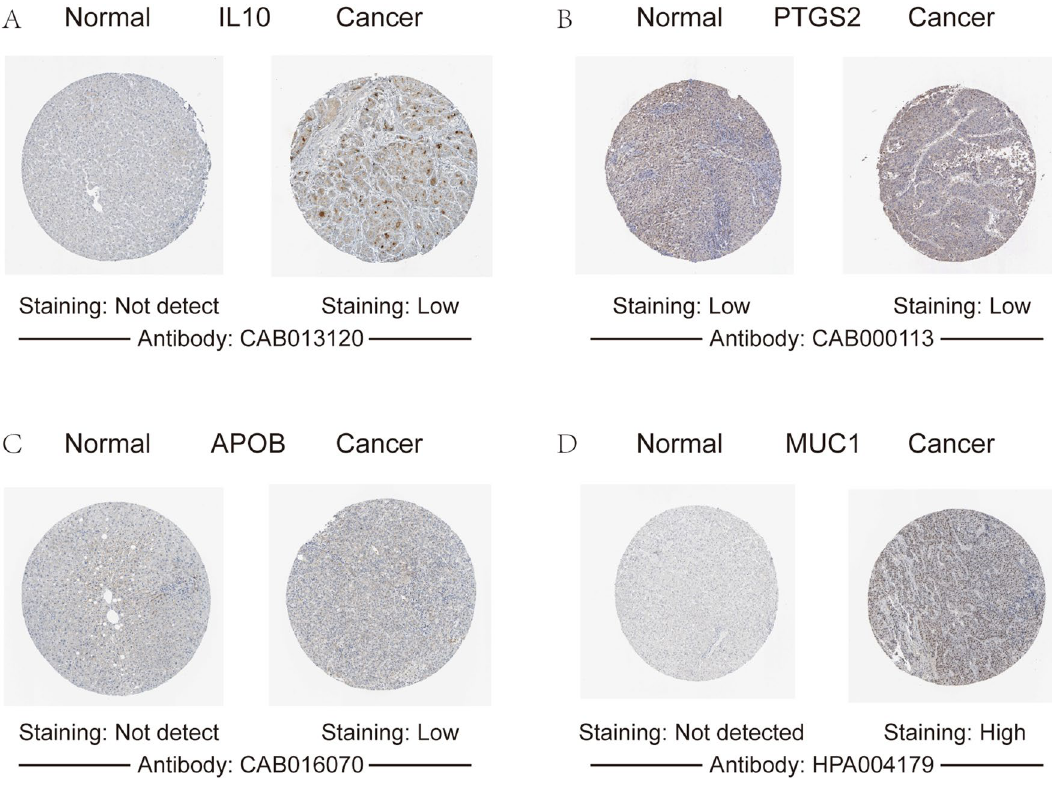
Figure 5. Immunohistochemistry images of four genes in HCC tissues and normal liver tissues. ( A ) IL10, ( B ) PTGS2, ( C ) APOB, ( D )